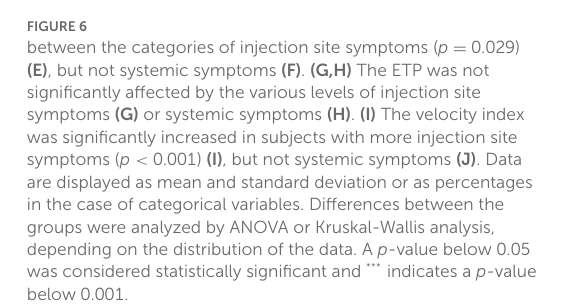
FIGURE6 between the categories of injection site symptoms ( p = 0.029) (E) , but not systemic symptoms (F) . (G,H) The ETP was not significantly affected by the various levels of injection site symptoms (G) or systemic symptoms (H) . (I) The velocity index was significantly increased in subjects with more injection site symptoms ( p < 0.001) (I) , but not systemic symptoms (J) . Data are displayed as mean and standard deviation or as percentages in the case of categorical variables. Differences between the groups were analyzed by ANOVA or Kruskal-Wallis analysis, depending on the distribution of the data. A p -value below 0.05 was considered statistically significant and *** indicates a p -value below